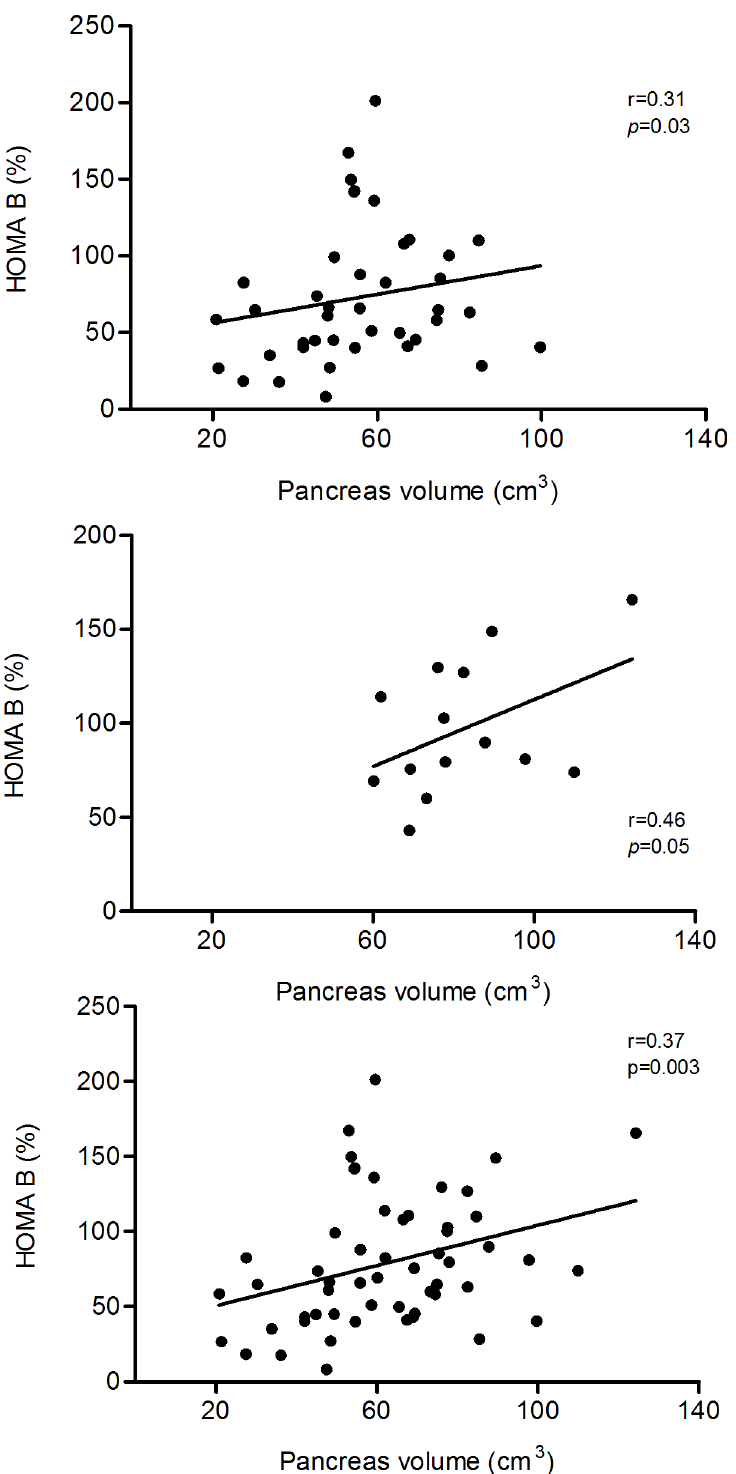
Fig 2. Relationships between HOMA- β (%) and pancreas volume (cm 3 ) in T2DM group (panel a), control group (panel b) and all subjects combined (panel c). In each case there was a positive correlation between pancreas volume and insulin secretion (Spearman